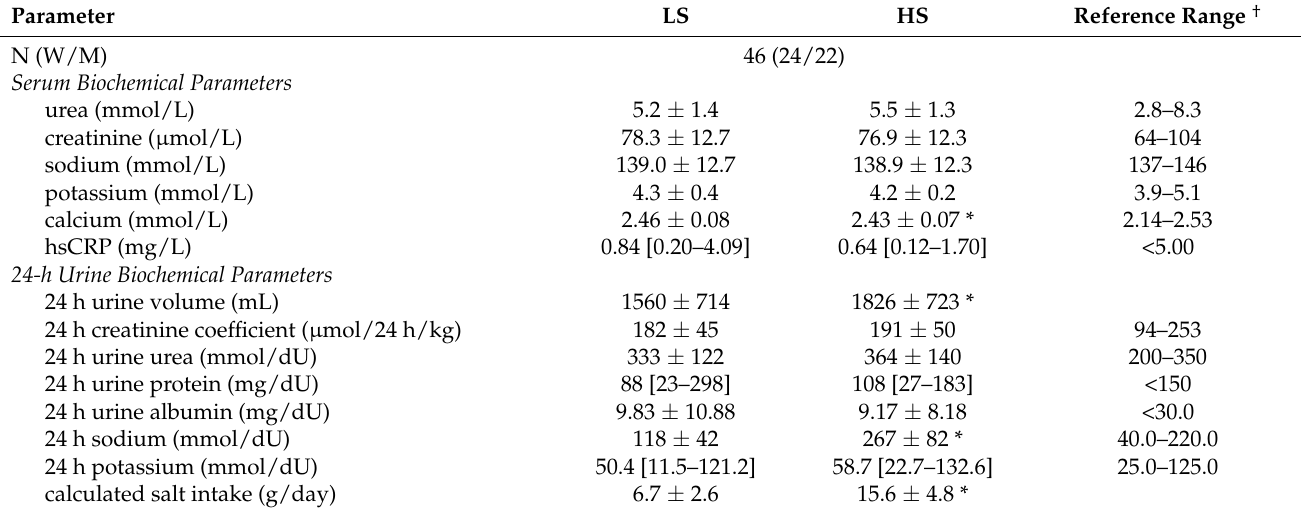
Table 2. Effects of a 7-Day High-Salt Diet on Standard Biochemical Venous Blood and 24-Hour Urine Parameters in Healthy